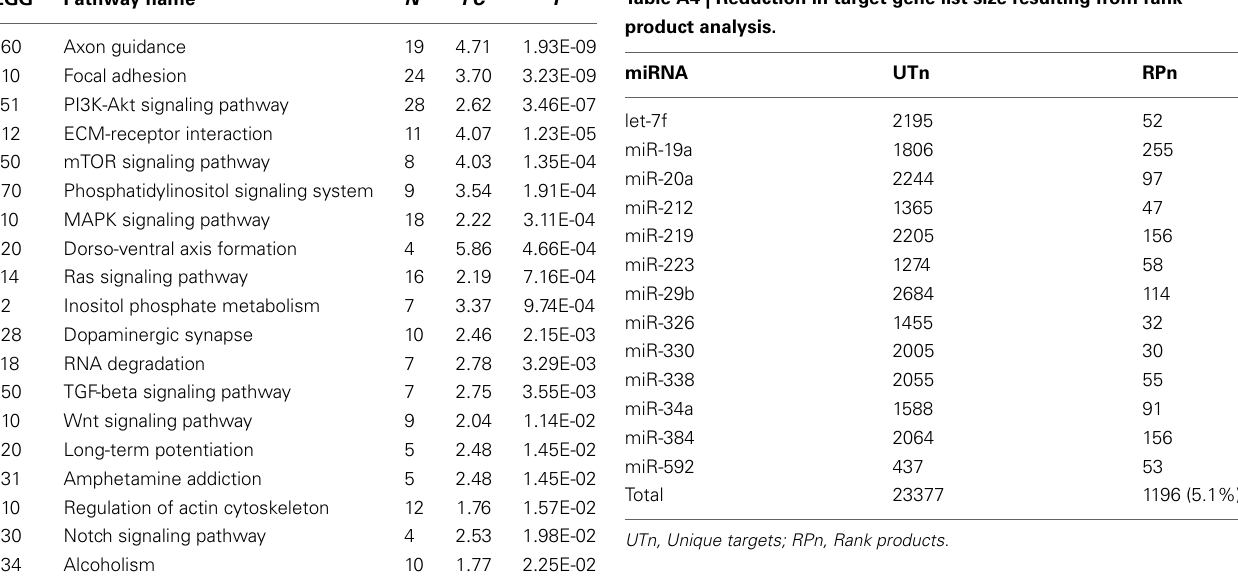
Table A2 | Neural related pathways enriched in targets with decreased activity-dependent Ago2 association. KEGG